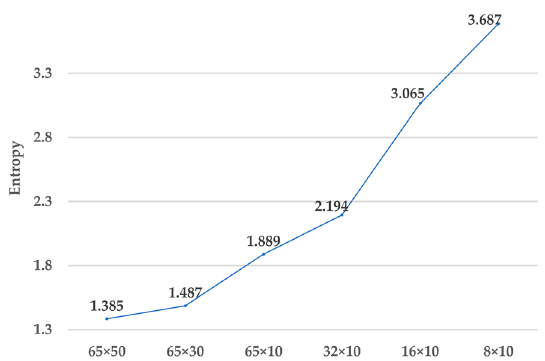
Figure 14. Comparison of entropy of spectrograms with different sizes.